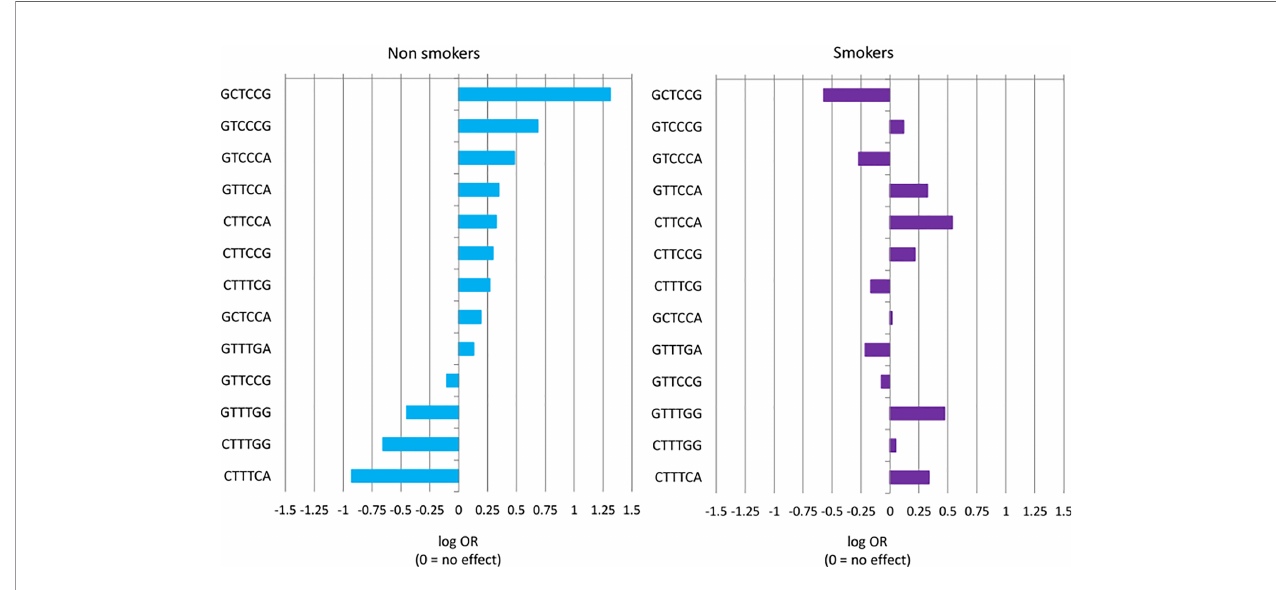
FIGURE 1 | Haplotype effect size of risk of NSCLC measured with log OR and sorted by effect in never-smokers group. A negative value of log OR (log OR < 0) corresponds to a protective effect of haplotype (OR < 1), while log OR > 0 corresponds to a predisposing haplotype effect (OR > 1). Differences in haplotype distributions between cases and controls were tested for smokers ( p = 0.3742) and never-smokers ( p = 0.03906).